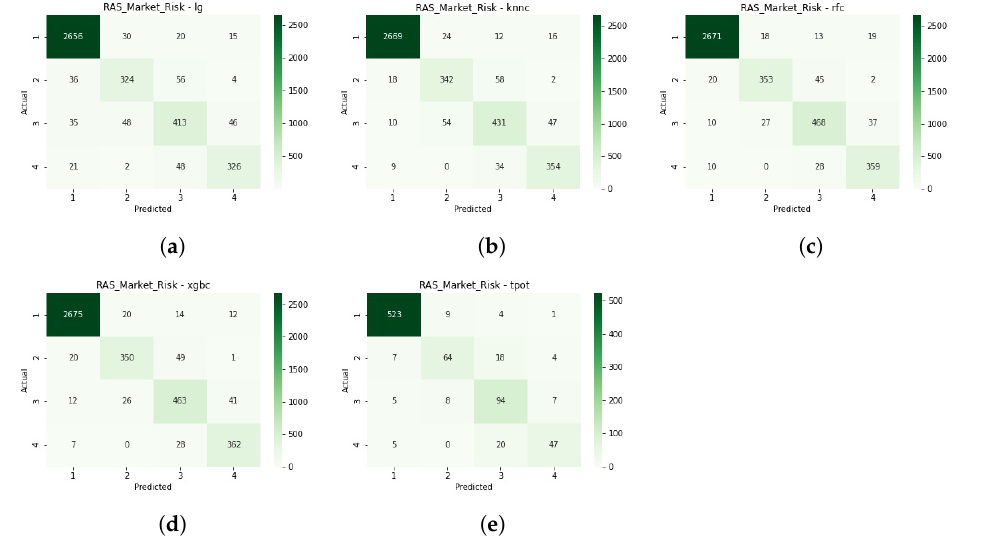
Figure A4. Market risk: confusion matrices generated when evaluating the above-mentioned models, using cross-validation approach. ( a ) Logistic Regression. ( b ) k-Nearest Neighbours classifier. ( c ) Ran- dom Forest classifier. ( d ) Extreme Gradient Boosting classifier. ( e ) TPOT classifier autoML